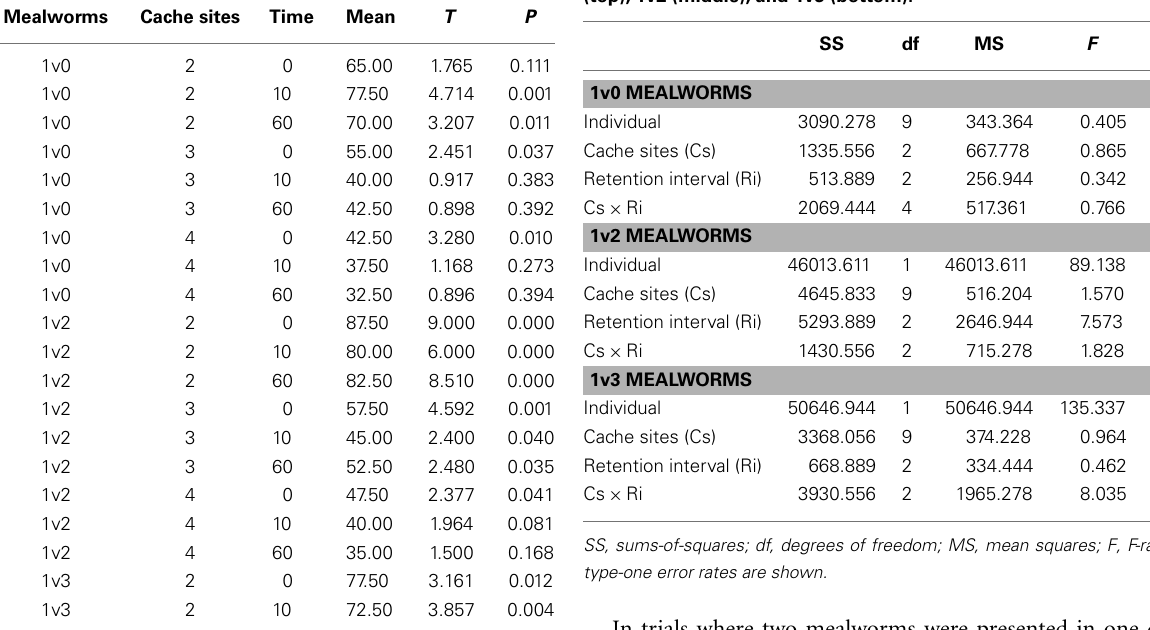
Table 1 | Single-sample t -tests for all combinations of variables. Table 2 | Results for general linear model analyses of variables 1v0 (top), 1v2 (middle), and 1v3